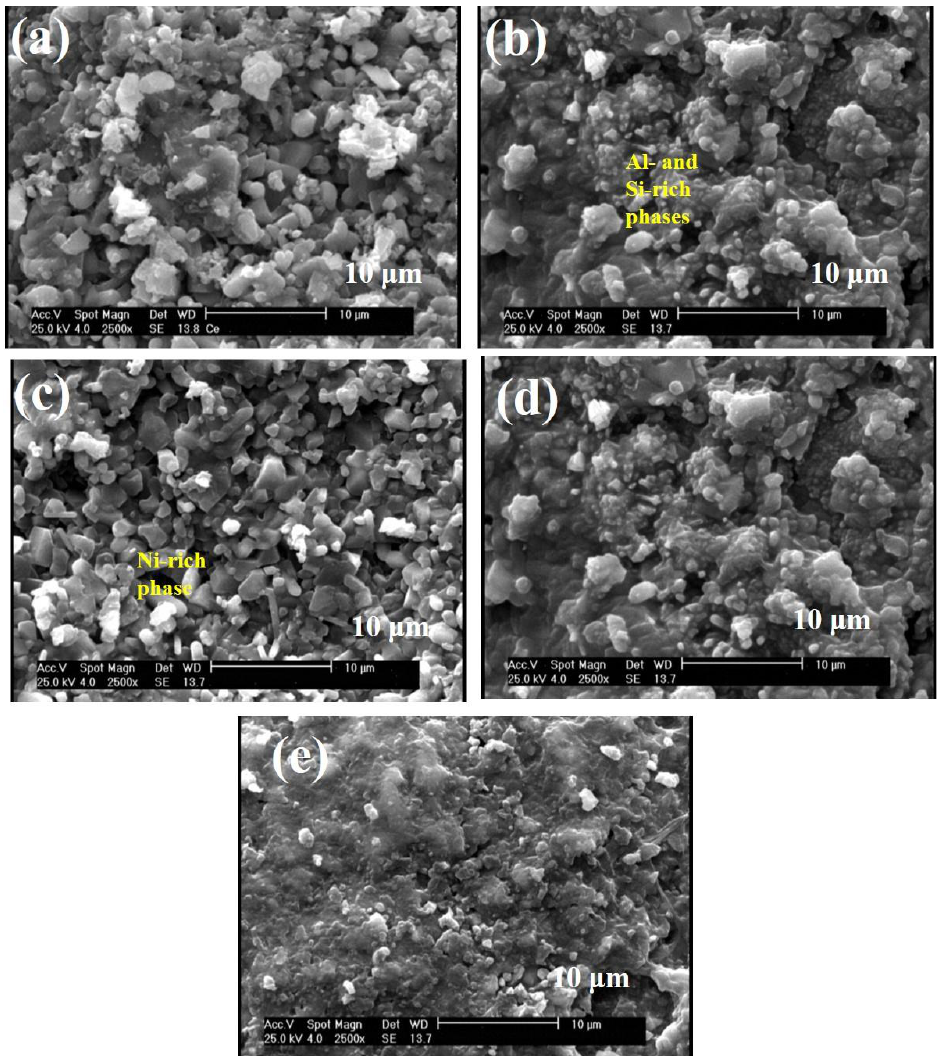
Figure 8. The surface SEM image after 50 cycles of oxidation tests at 1100 °C for ( a ) Ce1Si0, ( b ) Ce1Si6, ( c ) Ce0Si3, ( d ) Ce1Si3, and ( e ) Ce2Si3 coatings.